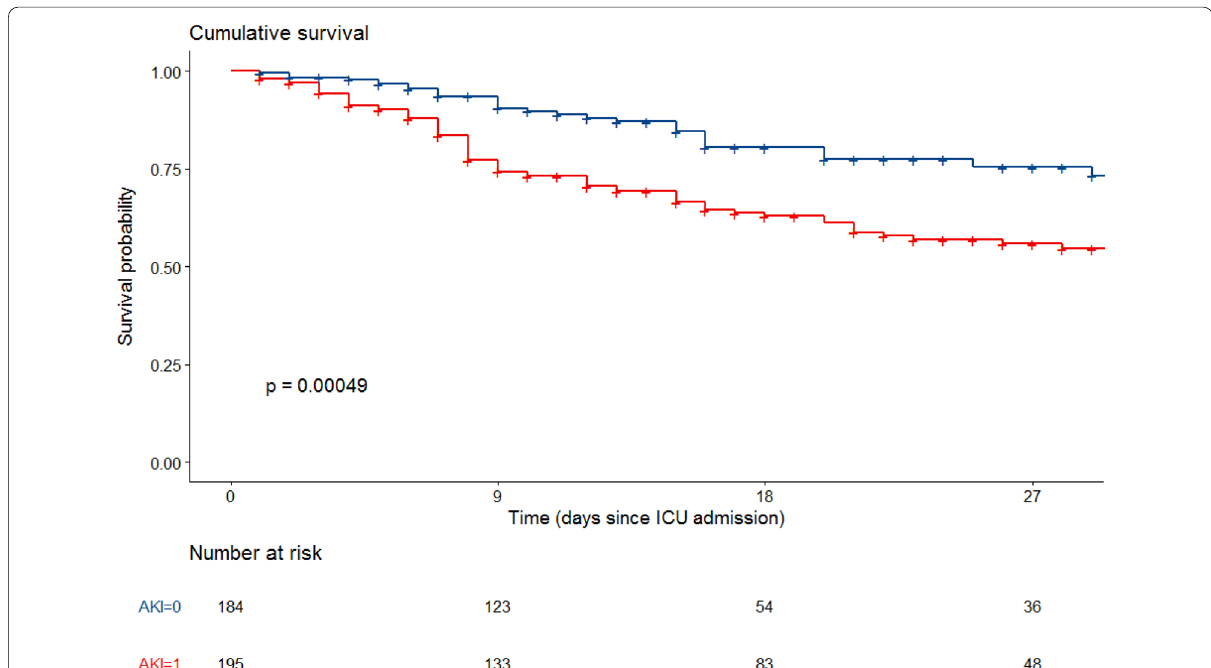
Fig. 2 Univariate Kaplan–Meier curves according to acute kidney injury